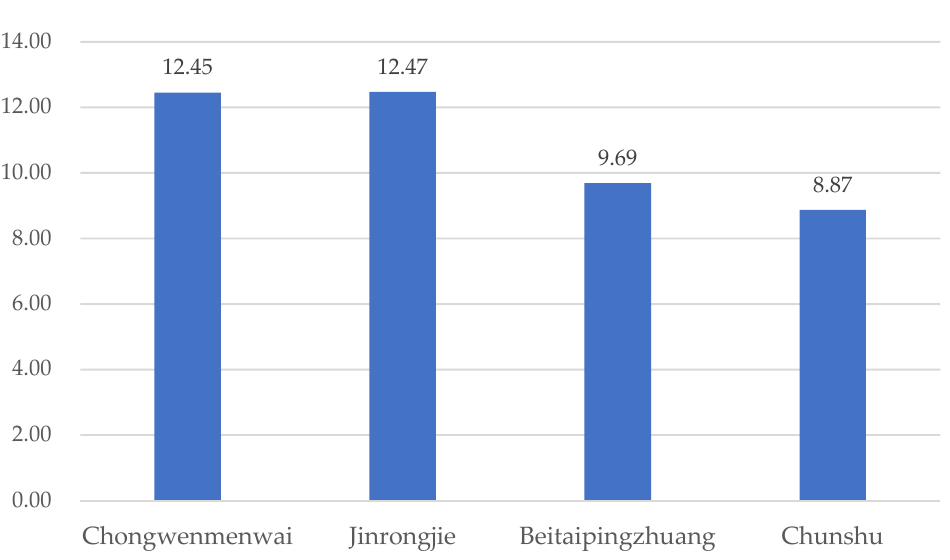
than the areas with low light